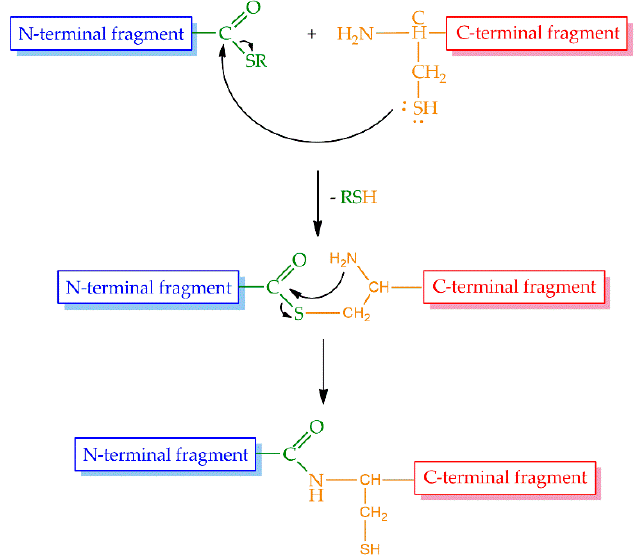
Figure 3. The process of native chemical ligation. 189